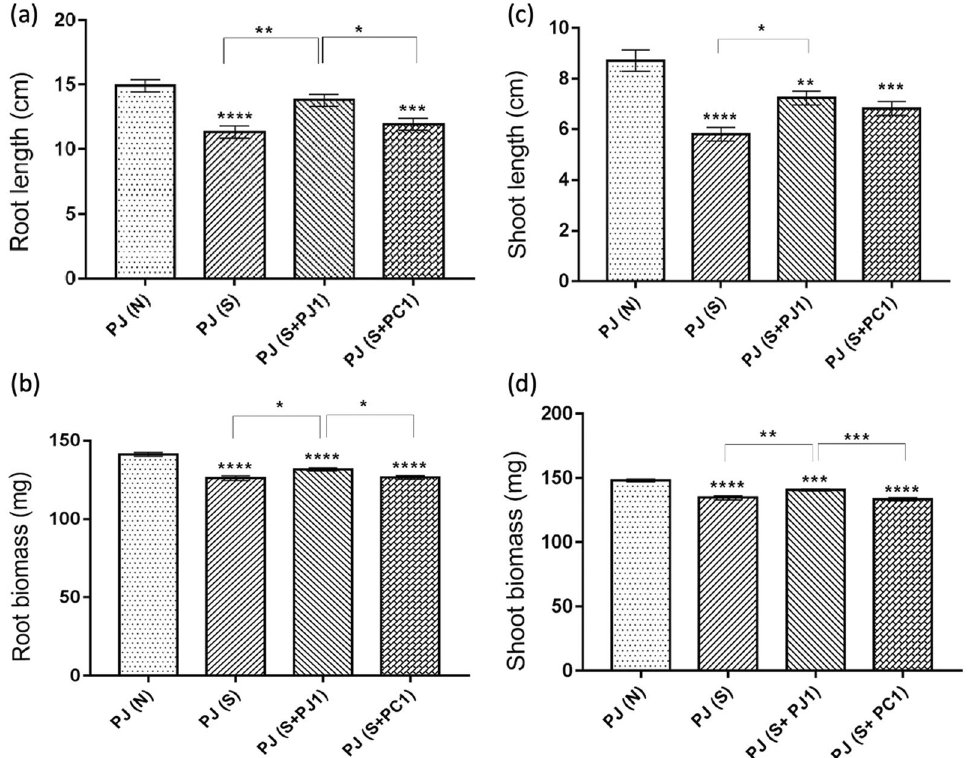
Fig. 3 Effect of soil inoculum on root length ( a ), root biomass ( b ), shoot length ( c ) and shoot biomass ( d ) of Prosopis juliflora . PJ: Prosopis juliflora ; PJ1: Streptomyces isolated from P. juliflora rhizosphere; PC1: Streptomyces isolated from Prosopis cineraria rhizosphere; (N), Natural garden soil; (S), Sterilized soil. All statistical analyses were carried out using one-way ANOVA followed by Tukey’s post hoc test. n **** p < 0.0001. Error bars represent standard